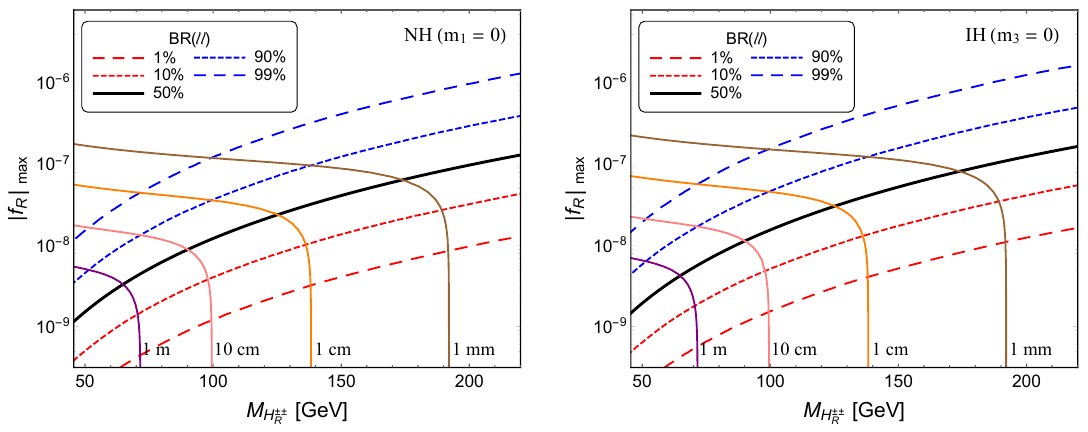
Figure 11 . Contours of proper decay length c(cid:28) 0 = 1 mm, 1 cm, 10 cm and 1 m of H (cid:6)(cid:6)